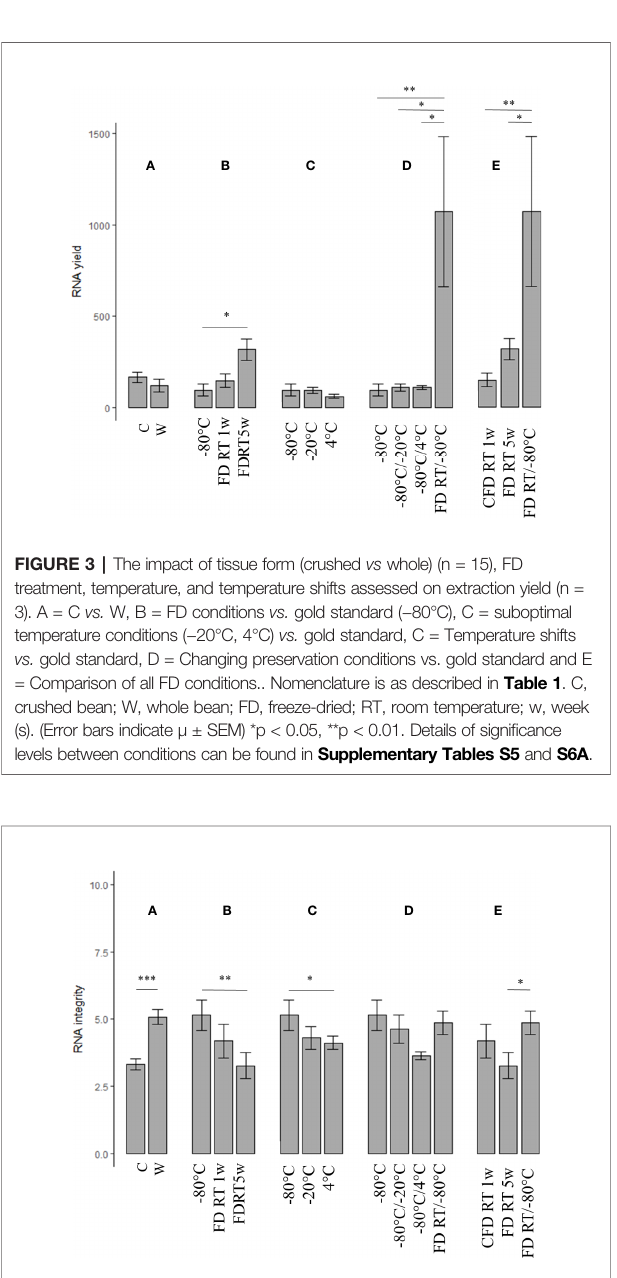
FIGURE 4 | The impact of tissue form (crushed vs whole) (n = 15), FD treatment, temperature, and temperature shifts assessed on RNA integrity (n = 3). A = C vs. W, B = FD conditions vs. gold standard ( − 80°C), C = suboptimal temperature conditions ( − 20°C, 4°C) vs. gold standard, C = Temperature shifts vs. gold standard, D = Changing preservation conditions vs. gold standard and E = Comparison of all FD conditions.. Nomenclature is as described in Table 1 . C, crushed bean; W, whole bean; FD, freeze-dried; RT, room temperature; w, week (s). (Error bars indicate mean ± standard error) *p < 0.05, **p < 0.01. Details of signi fi cance levels between conditions can be found in Supplementary Tables S5 and S6 fi ve weeks (FD RT 5w; p = 0.015) and non-FD samples continuously stored at 4°C (p = 0.040, column “ C vs W ” in Supplementary Table S5 ).